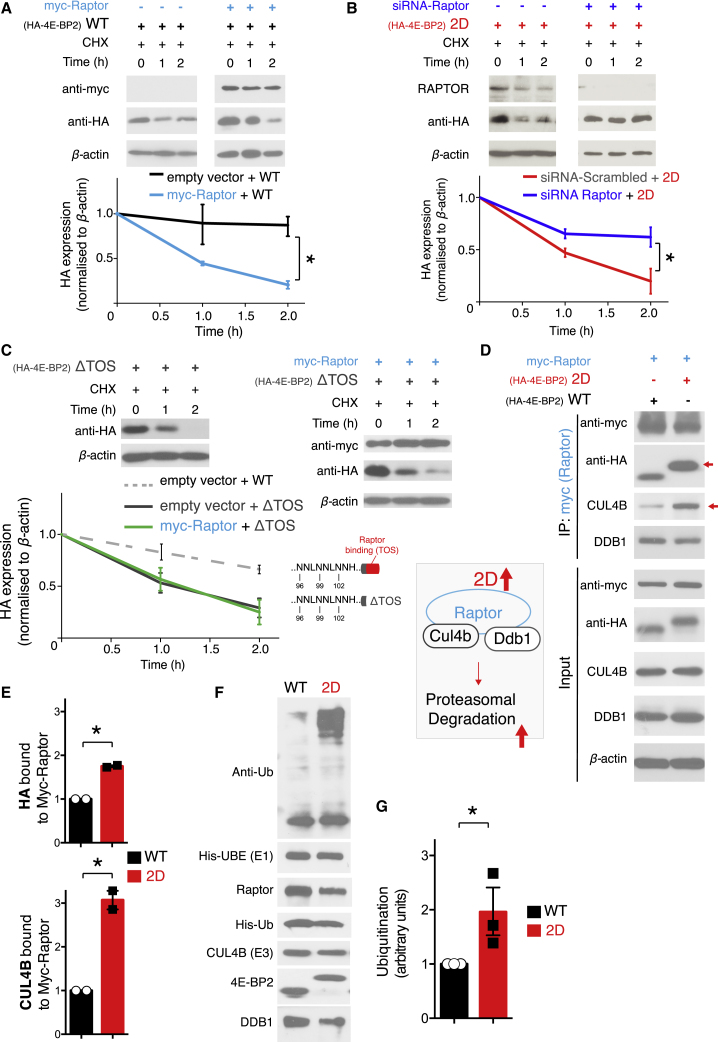
Increased Binding to Raptor and CUL4B Boosts 4E-BP2 Proteasomal Degradation(A–C) Top: representative immunoblots from HEK293H lysates co-transfected with myc-Raptor (A). WT HA-tagged 4E-BP2 and empty vector or myc-raptor (B) co-transfected with siRNA (scrambled or against RAPTOR) and 2D HA-tagged 4E-BP2, or (C) HA-4E-BP2 ΔTOS with empty vector or myc-Raptor + HA-4E-BP2 ΔTOS. Bottom: quantification of HA expression (corresponding to WT or 2D) measured by immunoblotting, normalized to β-actin. In (C, bottom), a depiction of 4E-BP2 domains is shown to highlight the C-terminal deletion of the TOS motif (ΔTOS).(D) Representative immunoblots from HEK293H immunoprecipitates (IP; top, with anti-myc antisera) and whole lysates (bottom), co-transfected with myc-Raptor and WT or 2D HA-tagged 4E-BP2 and probed with the antisera against the indicated proteins; β-actin is the loading control. The red arrow shows increased expression in IP. Right: depiction of the Raptor-CUL4B-DDB1-2D complex.(E) Quantification of data in (D) for HA expression and CUL4B bound to myc-Raptor, Student’s t test (n = 2),∗p < 0.05.(F) In vitro ubiquitination assay of purified GST-4E-BP2 WT or 2D. The reactions were performed in the presence of purified CUL4B, Raptor, DDB1, His-ubiquitin, UBE2L3, and UBE1 proteins and probed with the antisera against the indicated proteins. GST, glutathione S-transferase.(G) Quantification of ubiquitination data in (E); Student’s t test (n = 3); ∗p < 0.05.For (A)–(C), all of the experiments were carried out in the presence of 100 μg/mL cycloheximide (CHX) for 0, 1, or 2 h; β-actin is the loading control. The data are shown as means ± SEMs (error bars); n = 3 per condition; two-way ANOVA; Bonferroni’s post hoc; ∗∗p < 0.01, ∗∗p < 0.001.See also Figure S5 and Table S2.